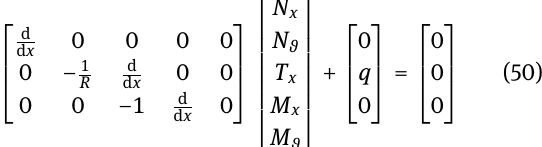
Figure 3: Cylindrical